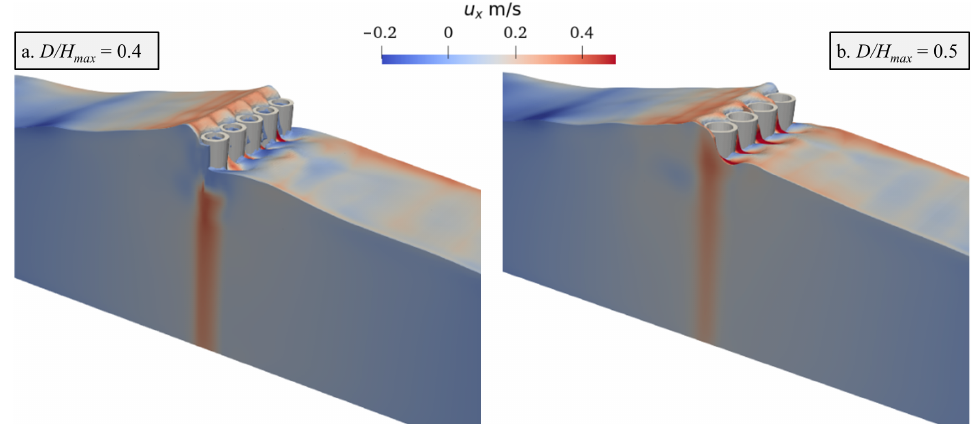
Figure 10. Simulated free surfaces with velocity magnitude (m/s) during the wave–structure interac- tion for different D/H max of non-perforated CPHBs.